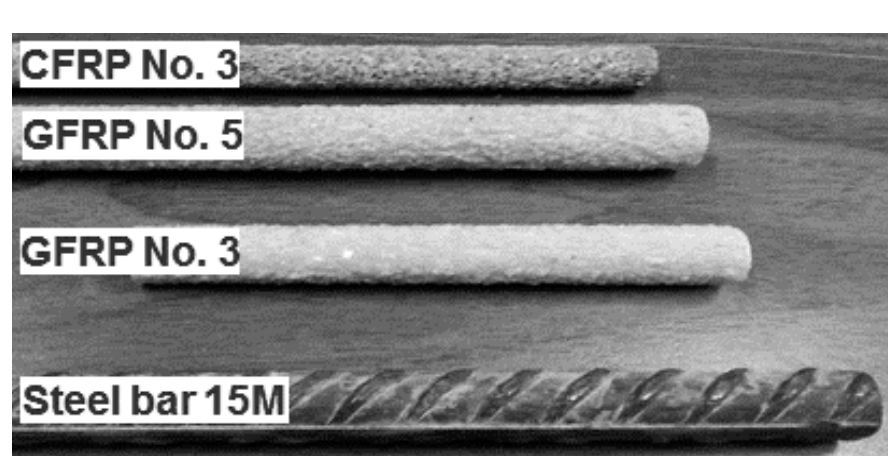
Figure 2. Different steel and fiber-reinforced polymer (FRP) bars used in this study.